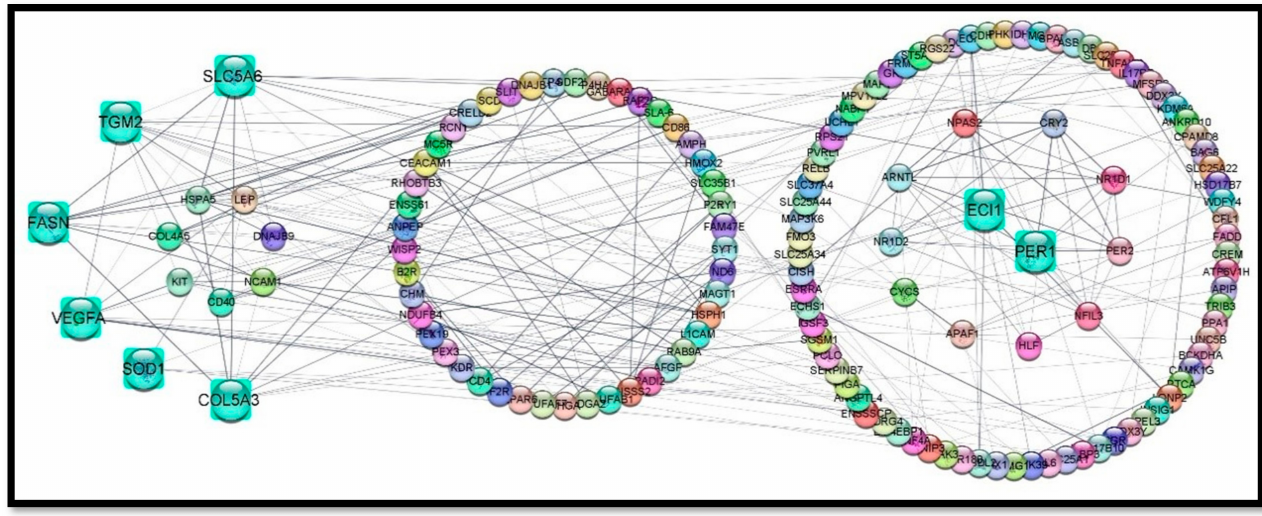
Figure 9. Protein-protein interaction network between the top 300 downregulated and upregulated DEGs in the IMF tissues of L_JN and D_JN by threshold p -value < 0.05 and fold change ≥